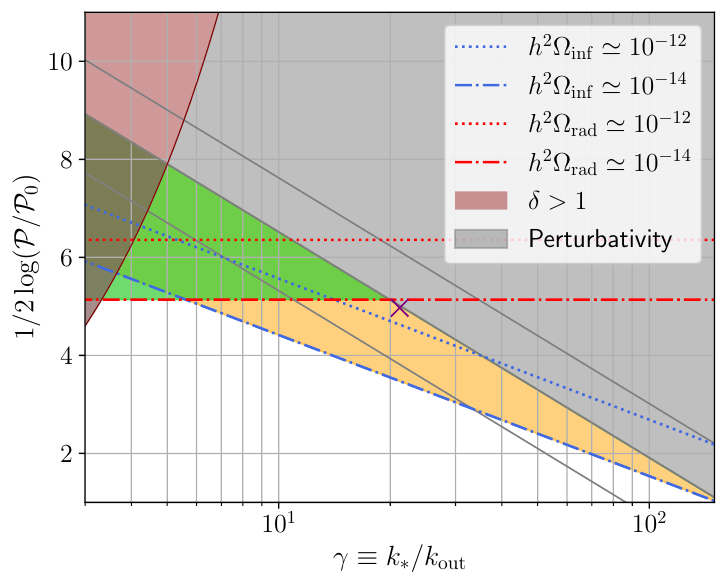
Figure 7 . Perturbativity constraints versus amplitudes of Ω GW . We highlight two values of constant Ω rad (red lines) and two values of constant Ω inf (blue lines) for a fixed (cid:15) = 0 . 05 . Their GW GW behaviour can be understood from eqs. (5.6)–(5.8). The grey lines correspond to the bound (5.4) with three different fudge factors C = 1 , 10 , 100 , i.e. larger C translates into decreasing constraining bounds. The grey area corresponds to the region of parameter space excluded by perturbativity constraints if C = 10 . Assuming that a signal is being potentially detectable if h 2 Ω GW & 10 − 14 , then the green area corresponds to the region of parameter space where Ω rad has observational relevance GW while the theoretical framework is under control. This allowed and relevant region of parameter space is extended by an additional strip (in yellow) once the Ω inf signal is also considered. For δ > 1 GW (red region) the feature described in section 4.7 is not sharp and the solutions for the Bogoliubov coefficients does not